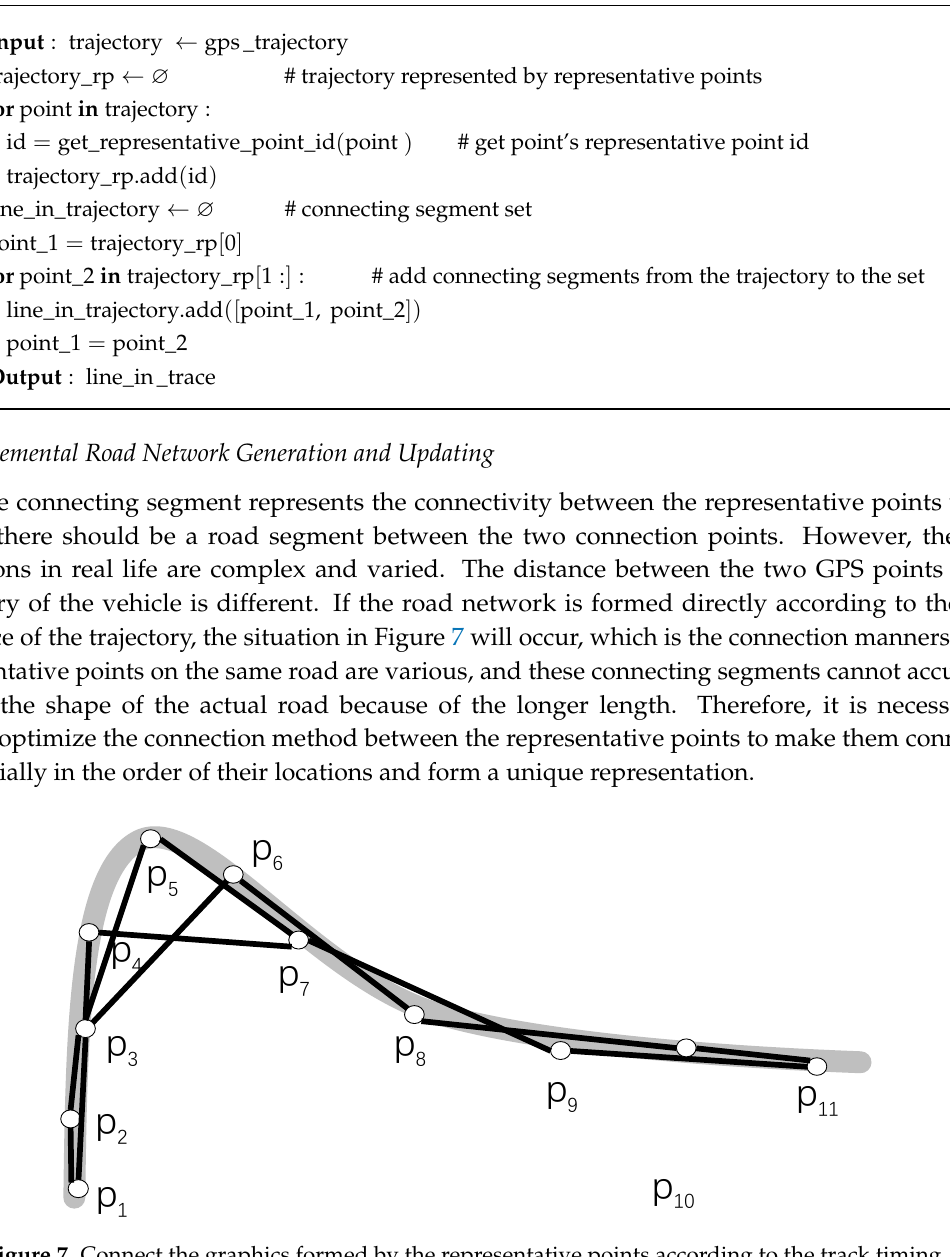
Figure 7. Connect the graphics formed by the representative points according to the track timing.